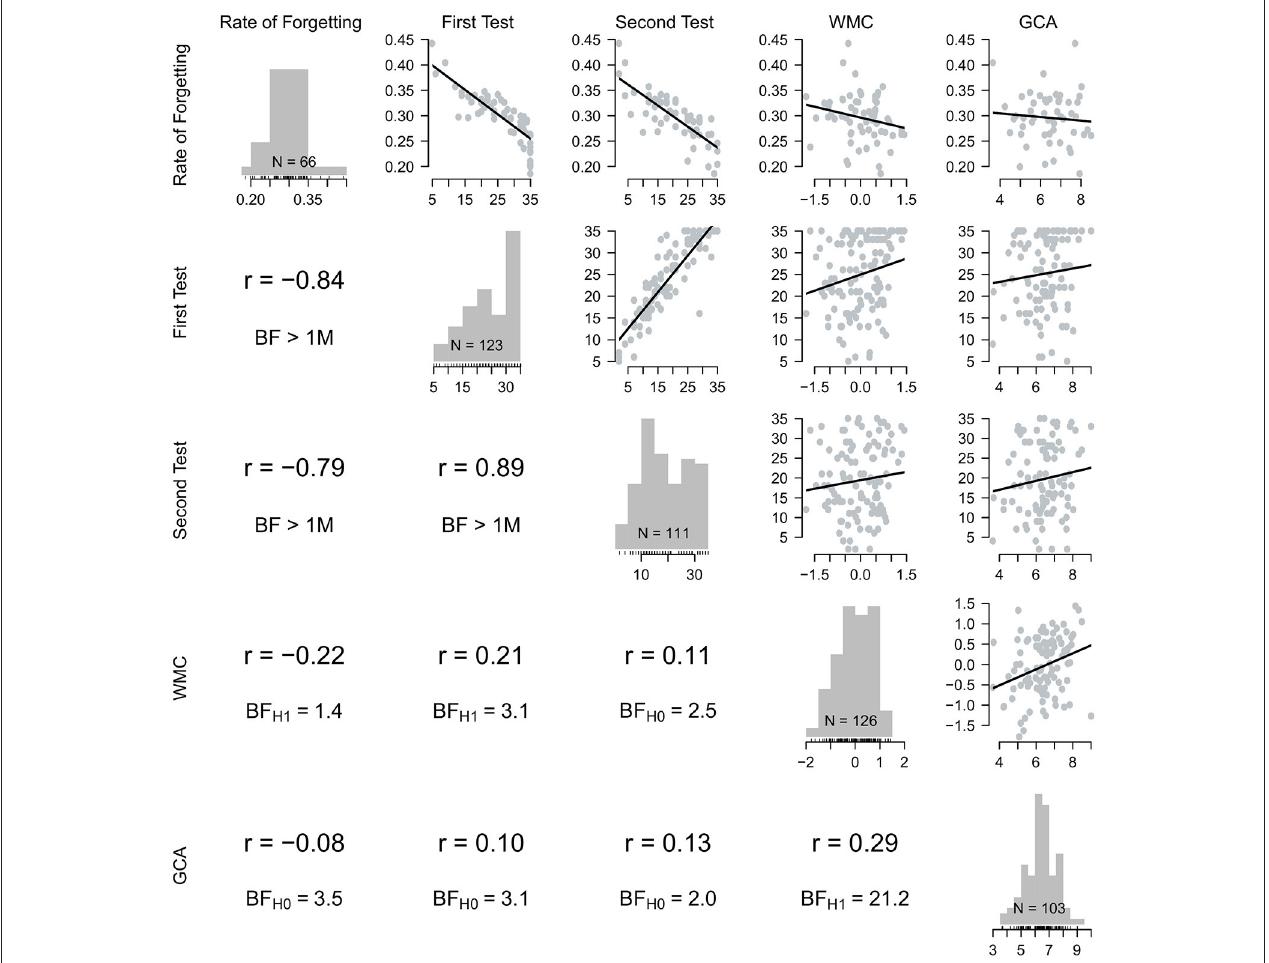
FIGURE 2 | Depicted are the measures of interest: the estimated rate of forgetting, the scores on the first and second Swahili-Dutch test, working memory capacity (WMC), and general cognitive ability (GCA). Note that Bayes factors correspond to the directional hypotheses that correlation coefficients are positive (except for the correlations with the rate of forgetting in the leftmost column: those are expected to be